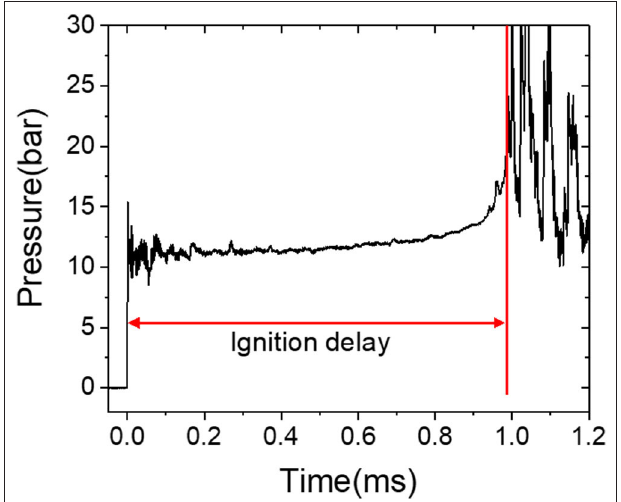
FIGURE 1 | Representative pressure profile for shock tube investigation of the methane/ethane